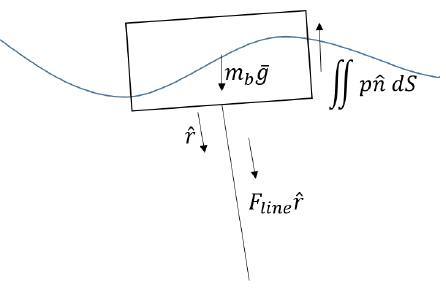
Figure 7. The forces acting on the buoy are the sum of the hydrodynamic, gravitational and generator ( F line ) forces adapted from [47] under the Creative Commons CC-BY